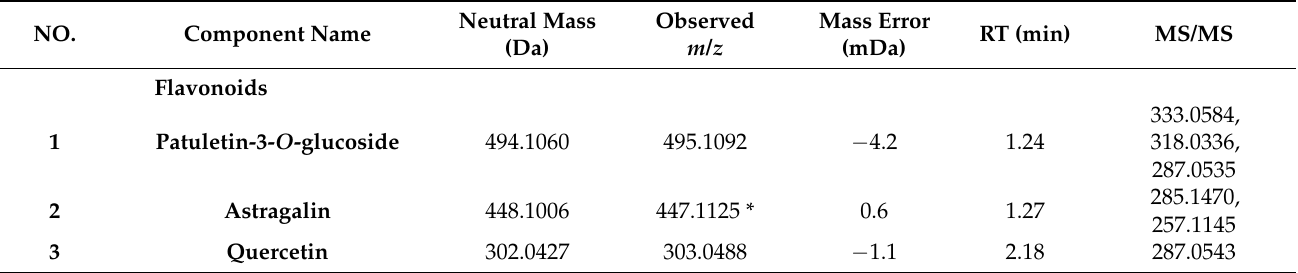
Table 3. Identification of Artemisia annua L. compounds based on UPLC-Q-TOF-MS/MS. ( n =